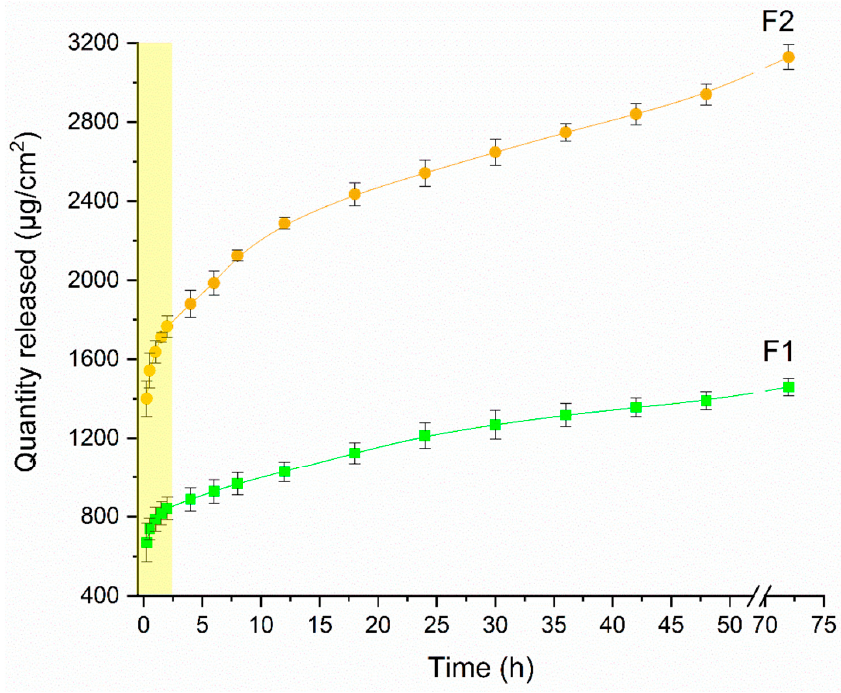
Figure 5. In vitro release profiles in Franz cell apparatus of the drug pentoxifylline incorporated into chitosan films at two concentrations, F1 (1.37 mg of pentoxifylline) and F2 (2.74 mg of pentoxifylline). Table 2. Linear evaluation of in vitro PTX (pentoxifylline) release mathematical models from CS films.